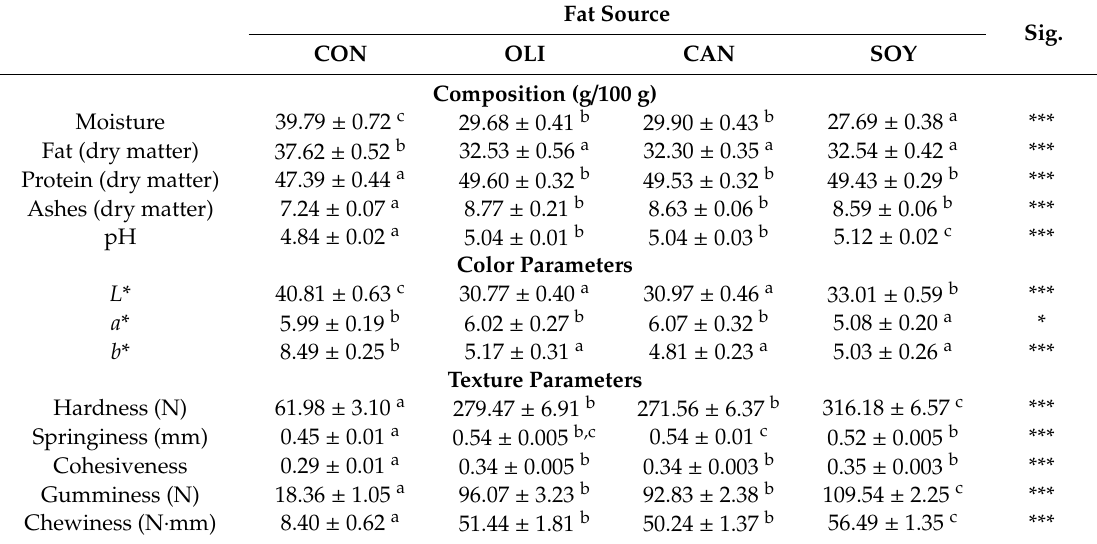
Table 2. E ff ect of fat source on physicochemical and composition parameters of dry-fermented deer